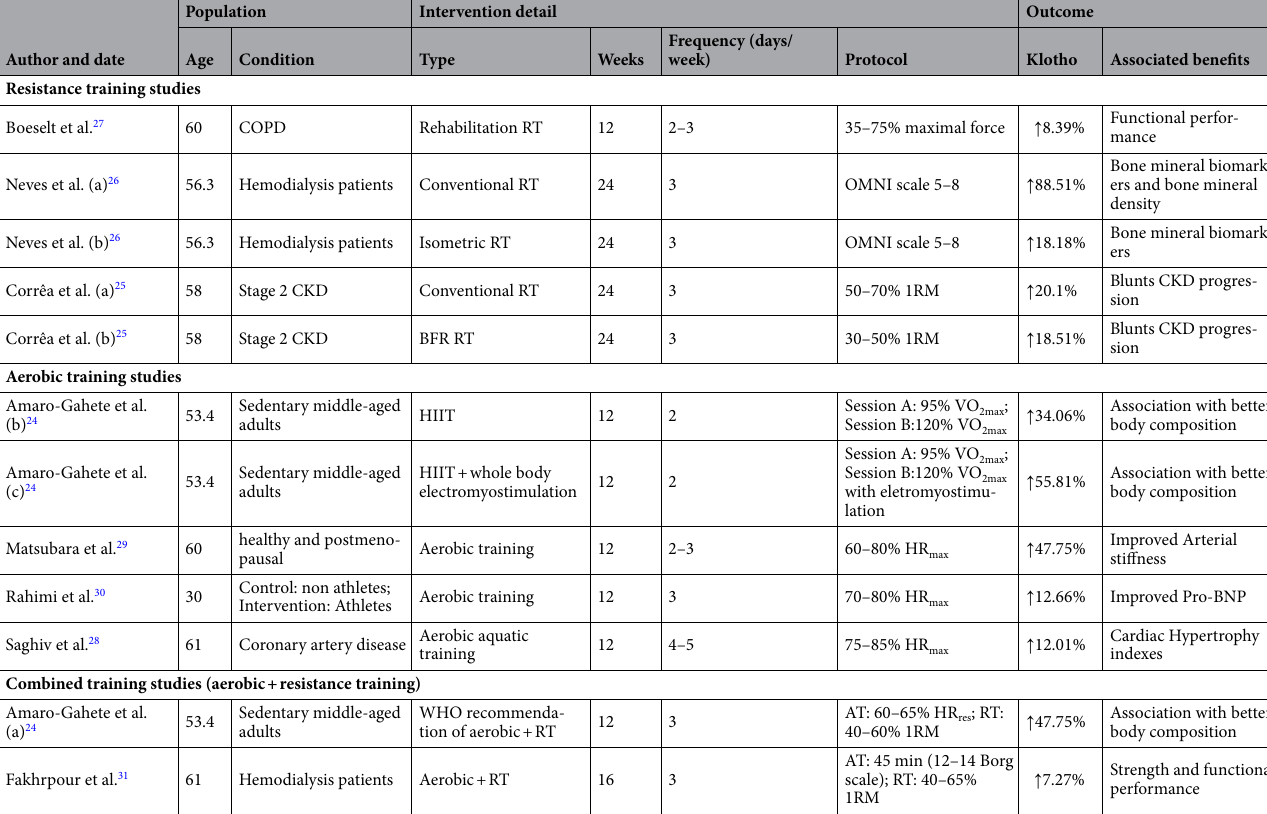
Table 1. Population characteristics, exercise training details, and outcomes. COPD chronic obstructive pulmonary disease, RT resistance training, CKD chronic kidney disease, BFR blood-flow restriction, 1RM